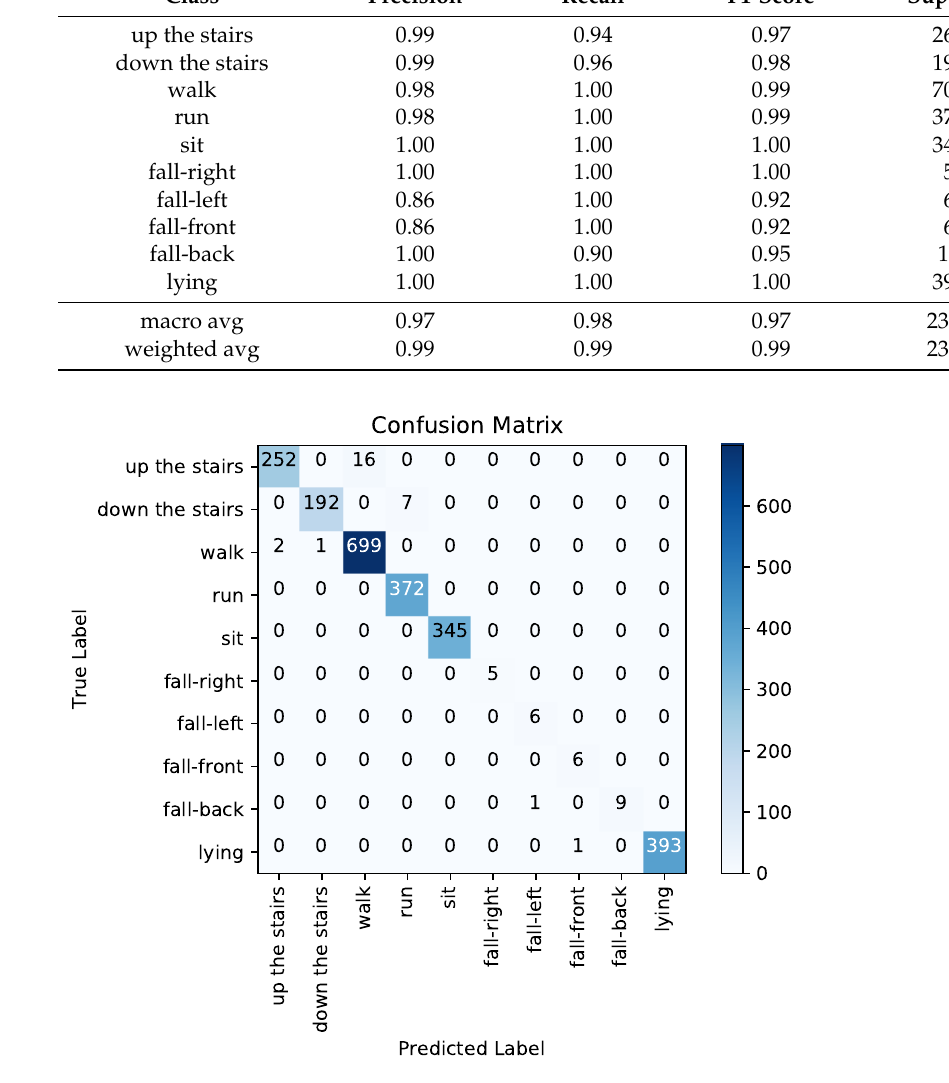
Figure 10. Confusion matrix using feature learning based